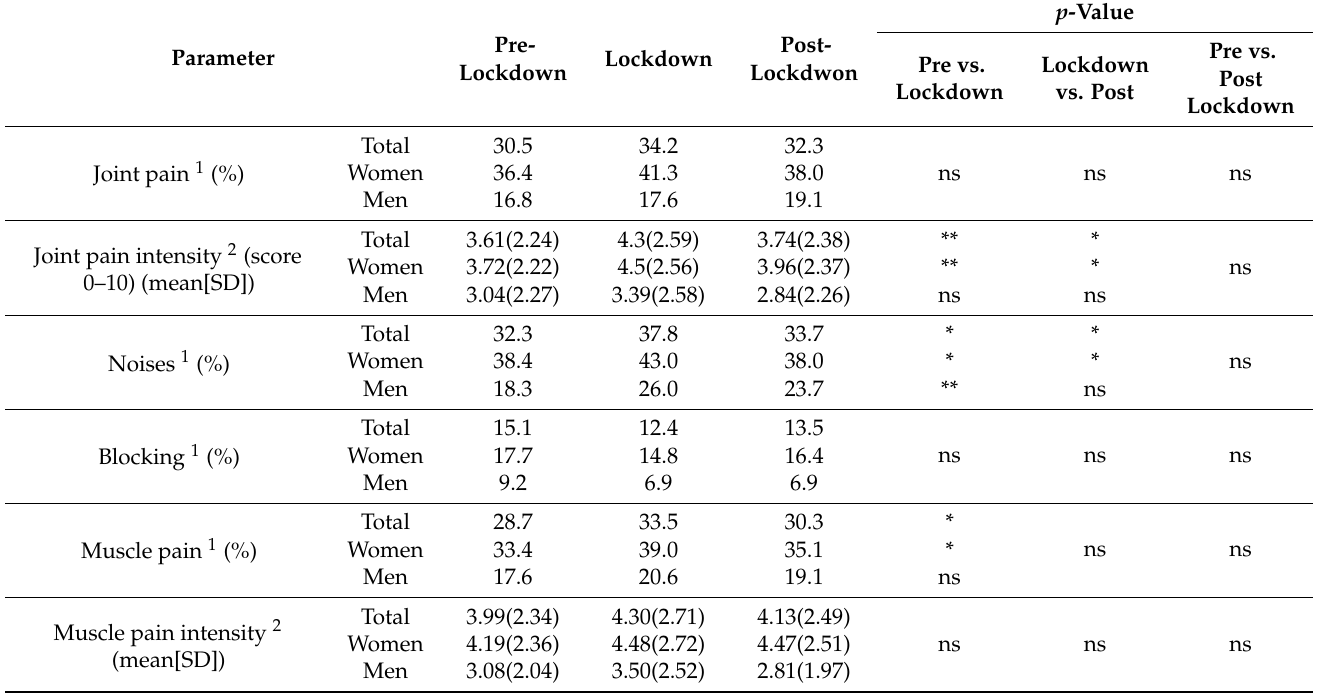
Table 5. Temporomandibular disorders (DC-TMD).